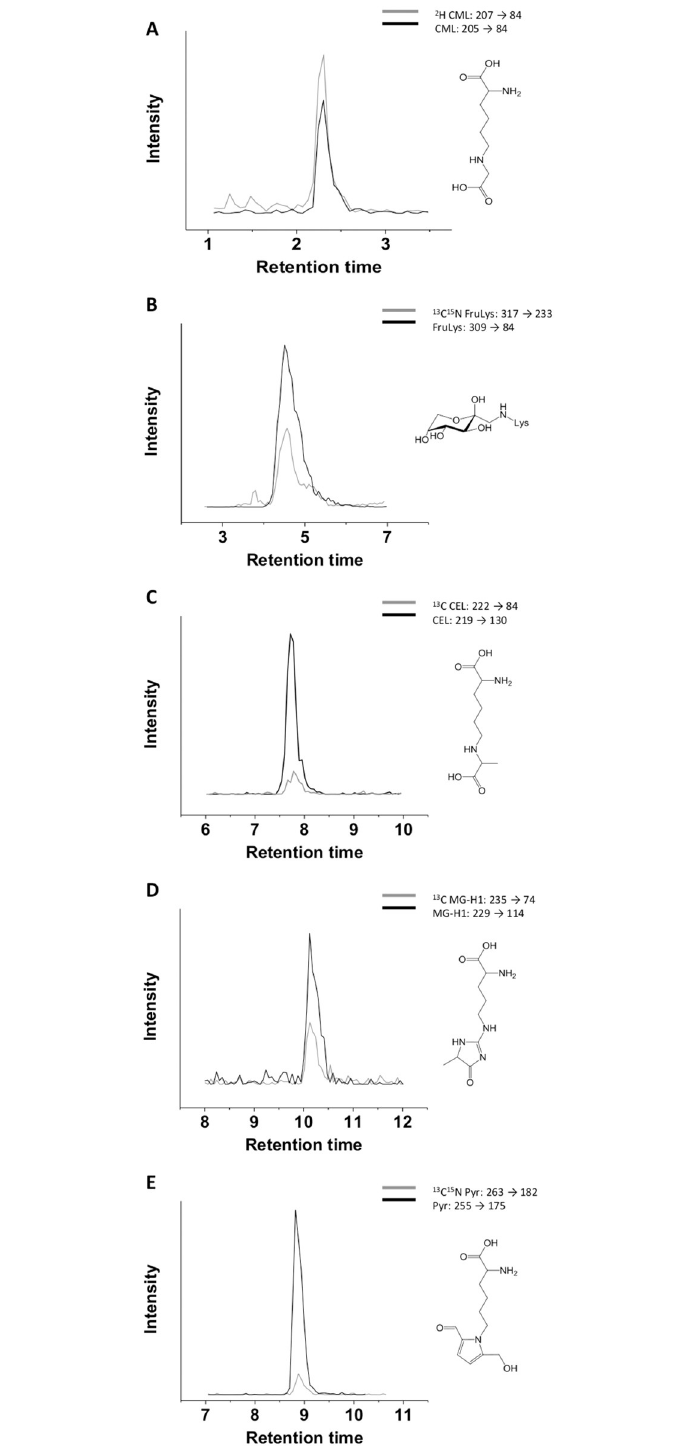
Fig 1. Chromatograms of the free MRPs A) CML, N ε -carboxymethyllysine; B) FruLys, N ε -fructosyllysine; C) CEL, N ε -carboxyethyllysine; D) MG-H1, methylglyoxal-derived hydroimidazolone 1 and E) Pyr, pyrraline in saliva. Each single analyte (grey) was analyzed in accordance with the corresponding isotopologue internal standard (black) by specific MRM transitions.